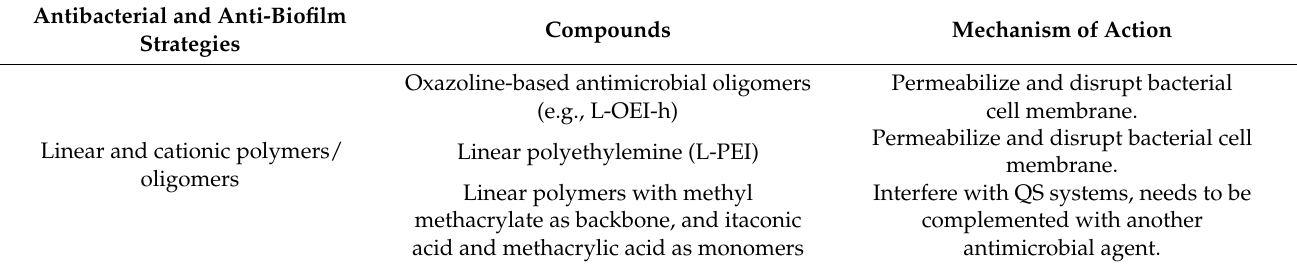
Table 1. Antibacterial and antibiofilm strategies and their mechanism of action. Antibacterial and Anti-Biofilm Compounds Mechanism of Action Strategies Oxazoline-based antimicrobial Linear and cationic polymers/ oligomers